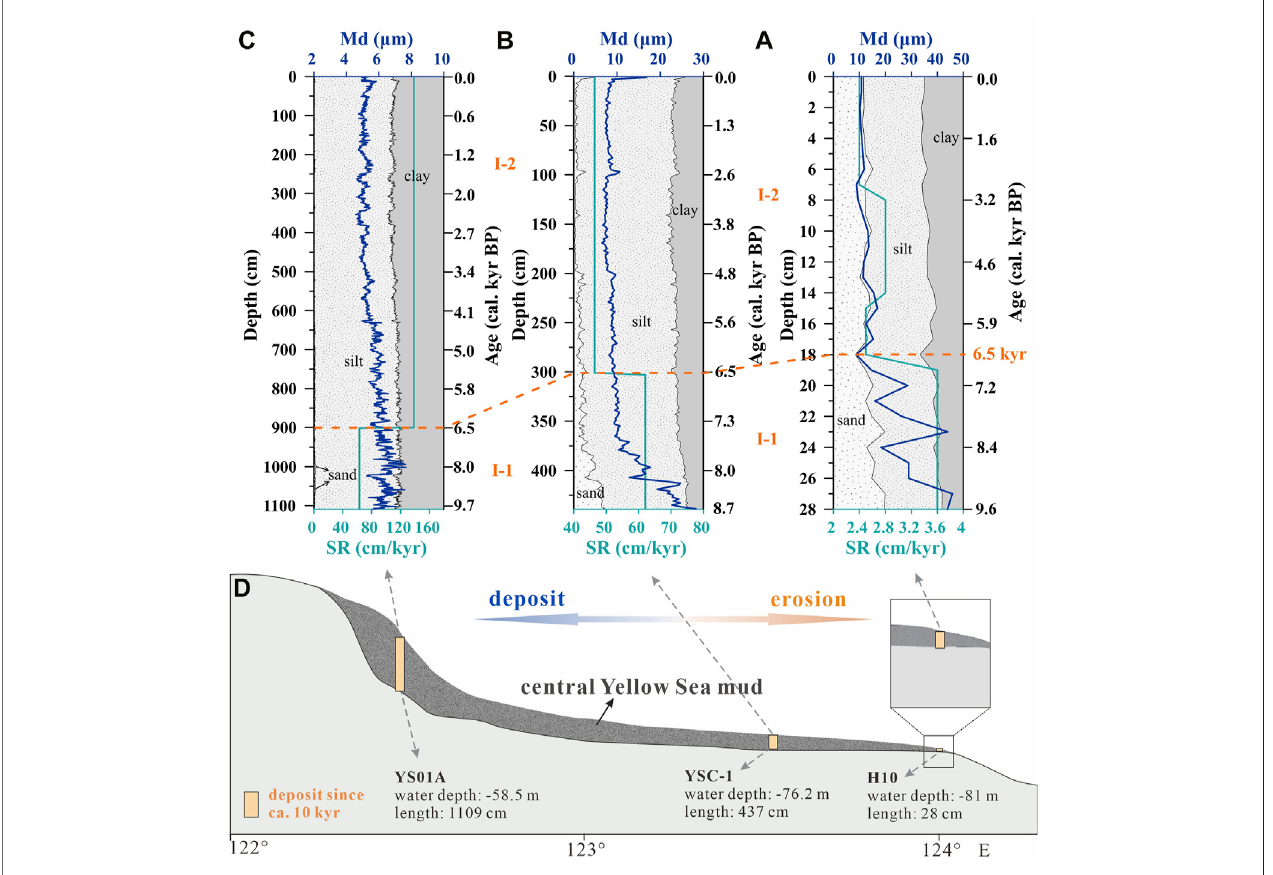
FIGURE10 | Comparison ofthe sedimentarycharacteristics ofcore H10 (A) , YSC-1(Hu et al., 2018) (B) , and YS01A (Wang et al., 2014b) (C) inthe central Yellow Sea mud. (D) is a perspective transverse section of the central Yellow Sea mud.